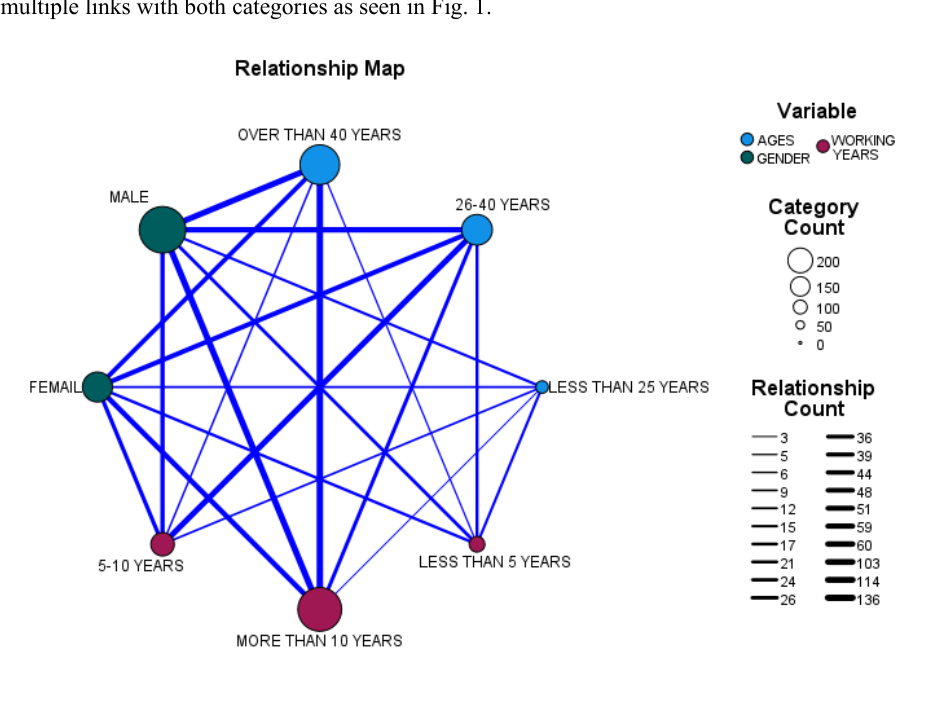
Fig. 1. Demographic of the connection and influencing of specified